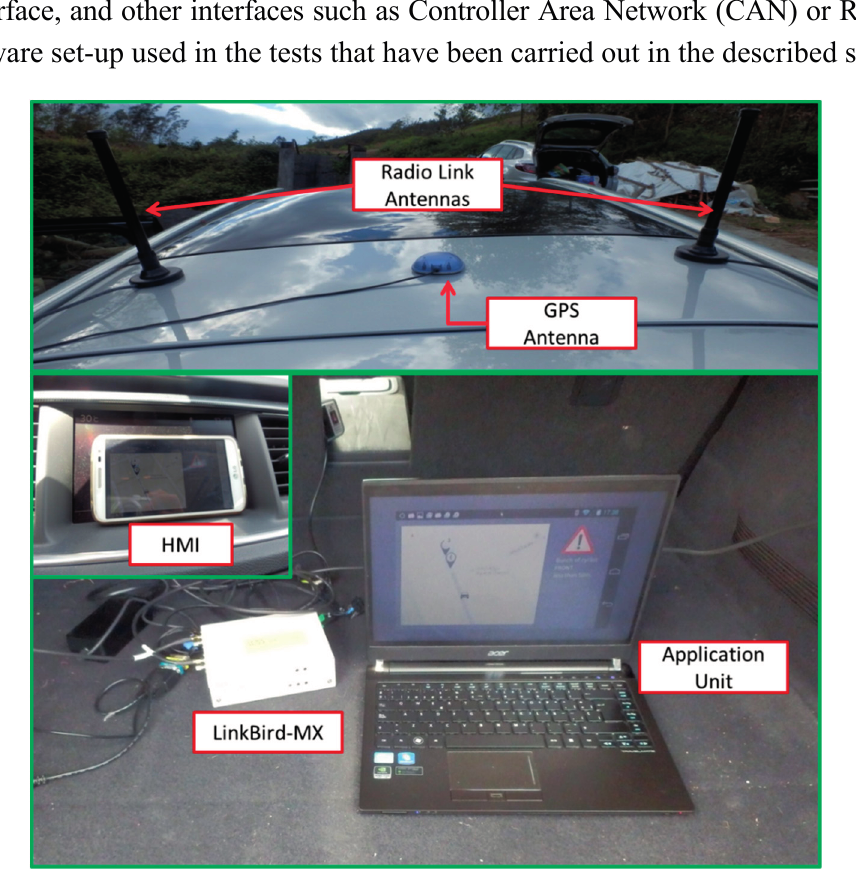
Figure 7. Hardware